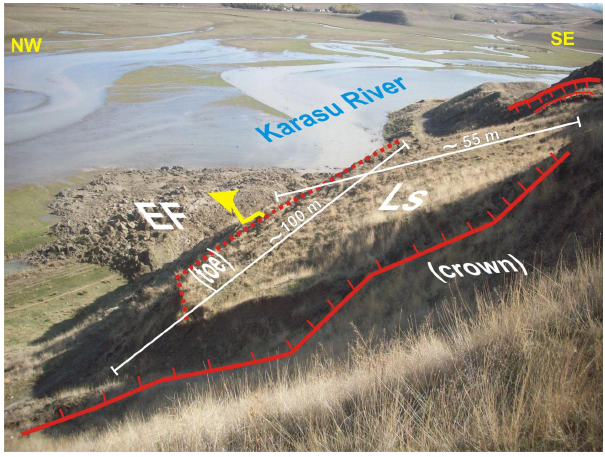
Figure 8. A view from an earth flow and landslide developed in Karasu Delta. 4 Fig. 8. A view from an earthflow and landslide that developed in 5 Karasu Delta.